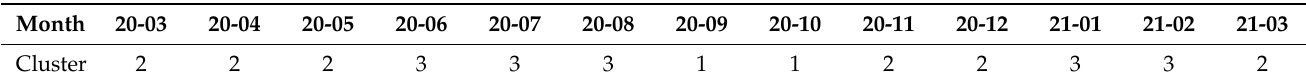
Table 12. Membership of the listed cluster for the number of COVID-19 deaths in the indicated month using the k-means